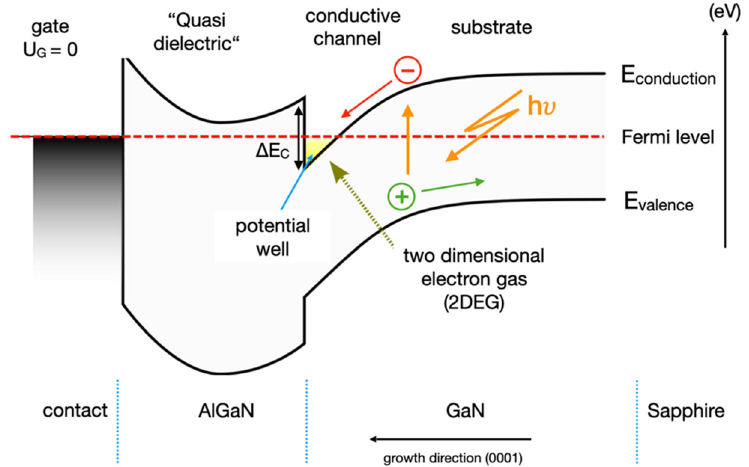
Figure 5. Energy band diagram of a HEMT with 2D electron gas. Schematic representation of the band-bending of the conductive band at the GaN/AlGaN material interface. The conduction band is bent below the Fermi level, which leads to an accumulation of free electrons in the potential well.